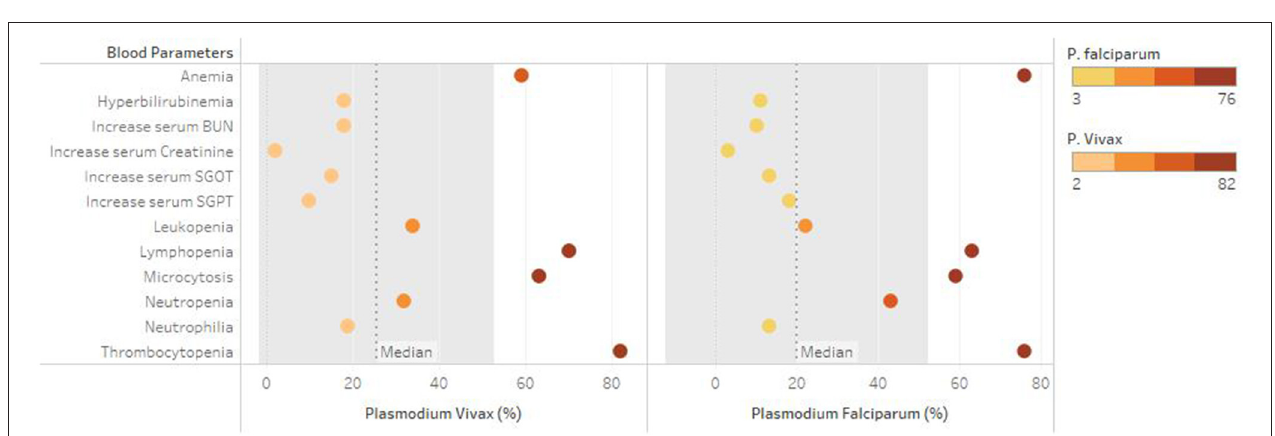
FIGURE 4 | Commonly seen laboratory parameters among both P. Vivax and P. falciparum .